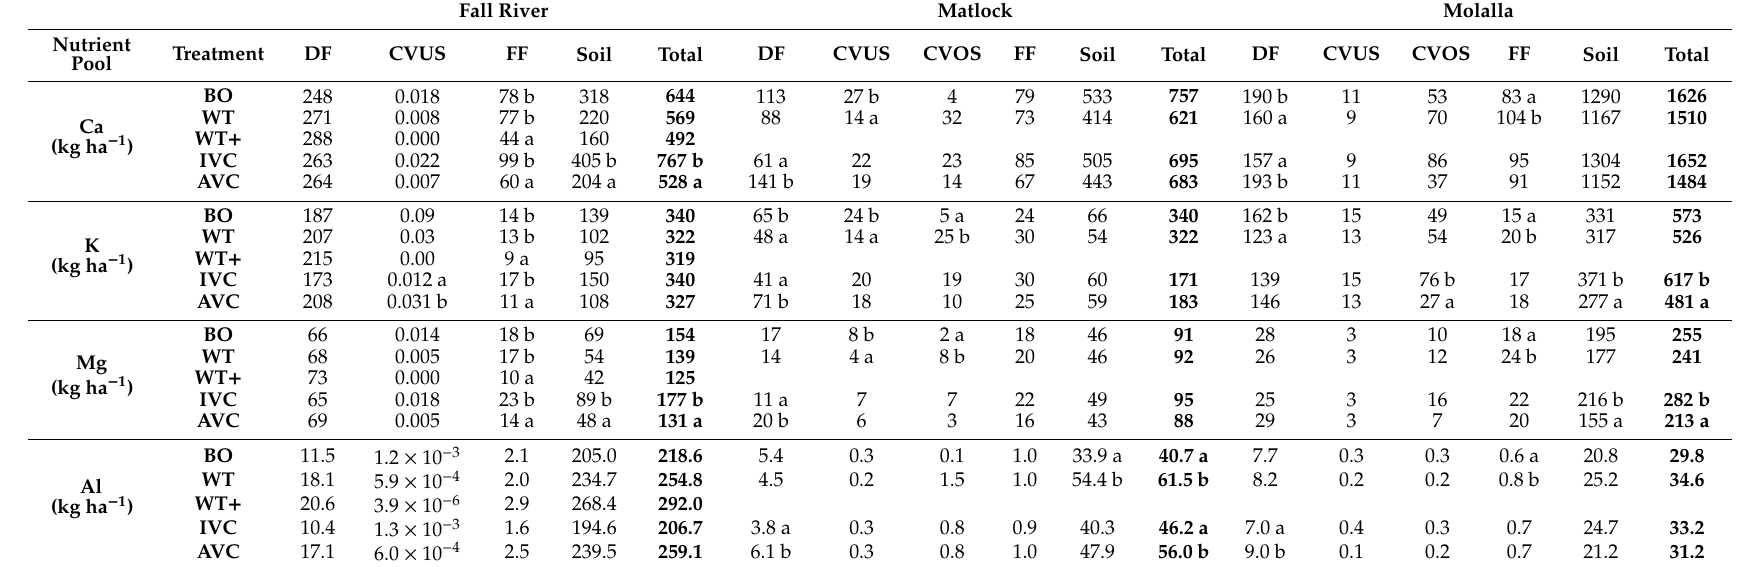
Table A2. Aboveground and belowground Ca, K, Mg, and Al nutrient pools at Fall River, Matlock, and Molalla. Values with di ff erent lowercase letters are